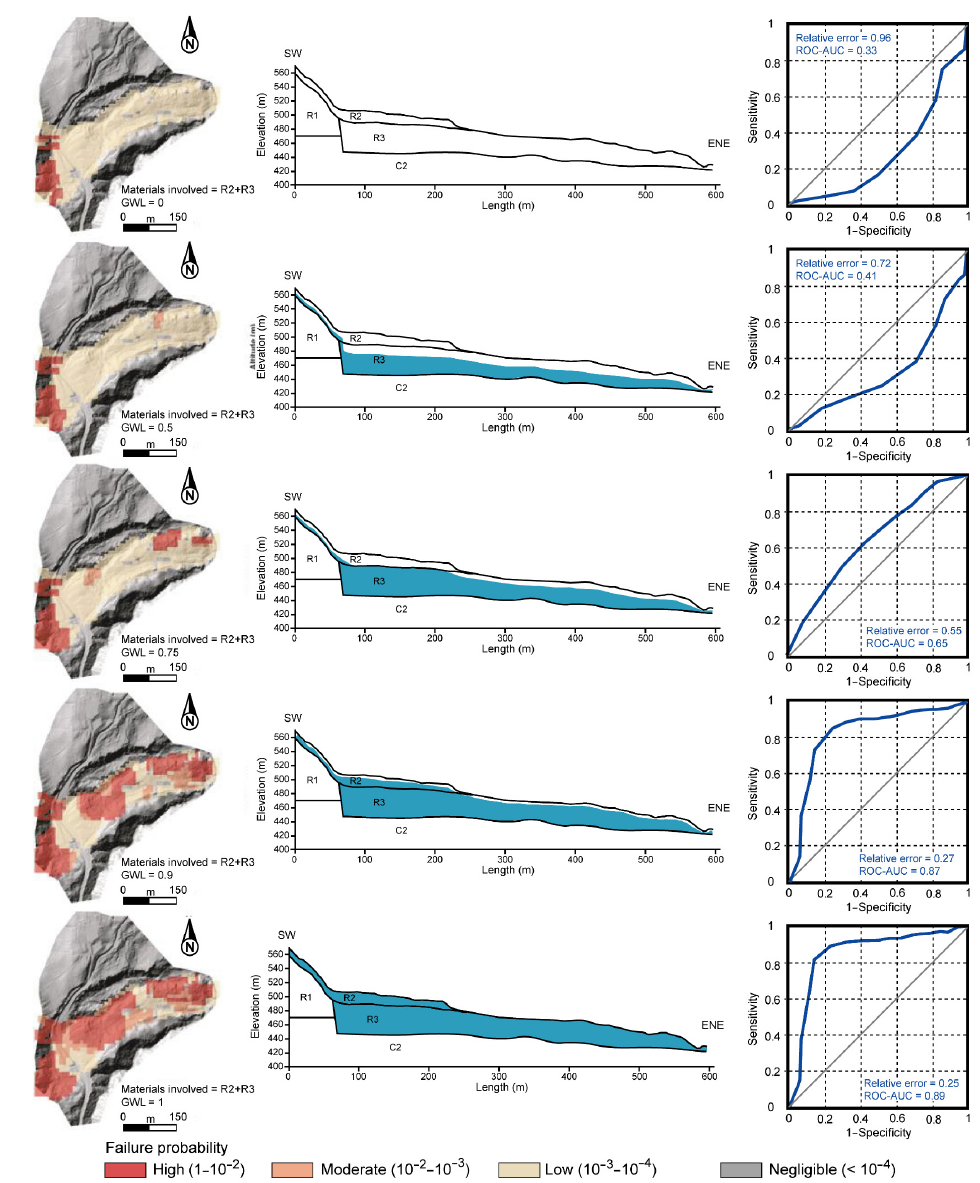
Figure 14. Influence of the GWL on computed failure probabilities with ALICE ® for the La M é daille landslide. The materials involved are R2+R3. Hillshade maps were produced with Helimap DTM (2013).